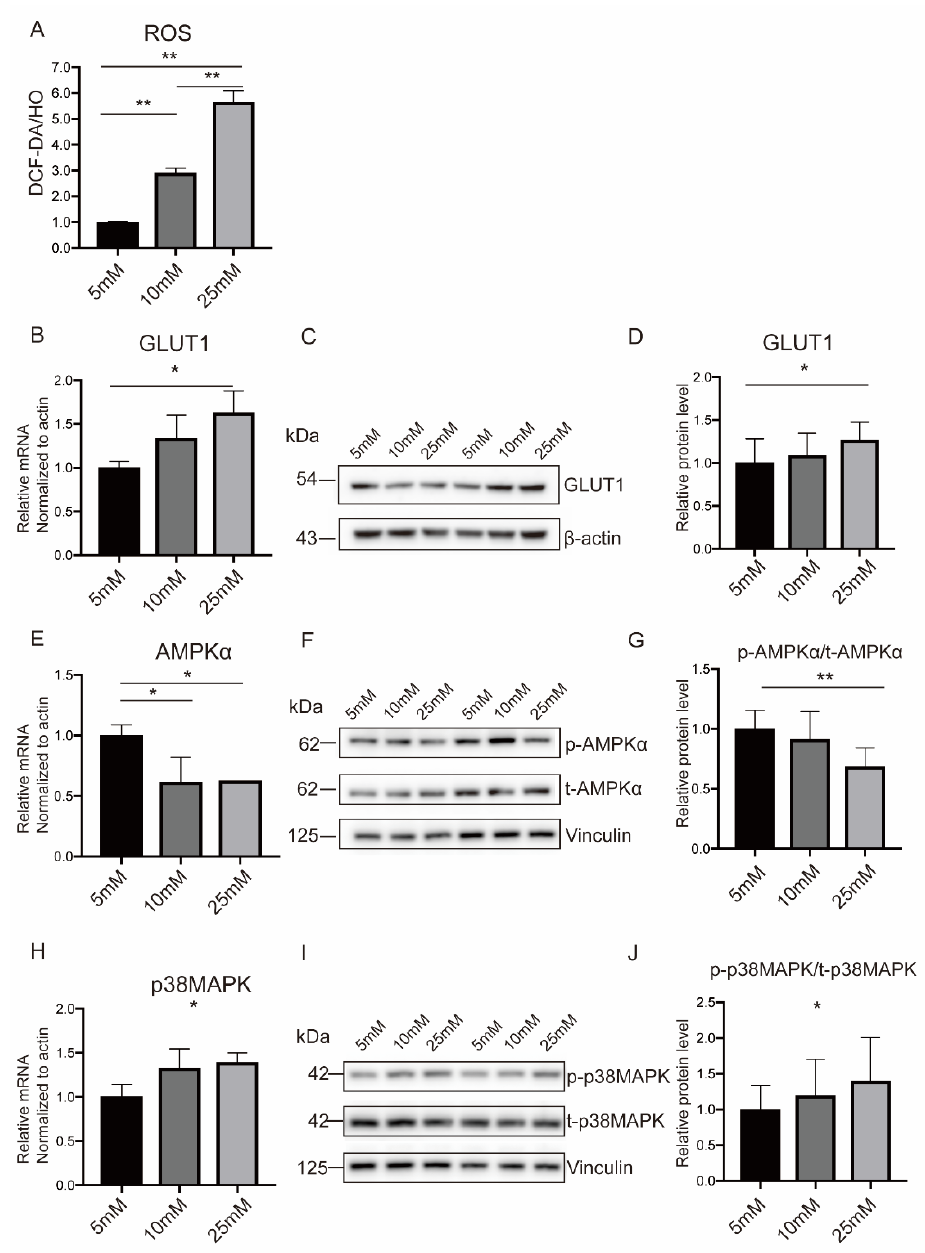
Figure 4. The oxidative status and expression levels of AMPKα, p38MAPK, and GLUT1 were altered in in vitro trophoblasts cultured in a high-glucose medium. ( A ) Intracellular ROS level in normal or high-glucose medium. ( B – J ) Cellular mRNA and protein levels of AMPKα ( B – D ), p38MAPK ( E – G ), and GLUT1 ( H – J ) cultured in normal or high-glucose medium. Actin and Vinculin served as the internal controls. Data are the mean ± SEM. * p < 0.05 and ** p < 0.01 by a one-way ANOVA test, followed by a post hoc test.